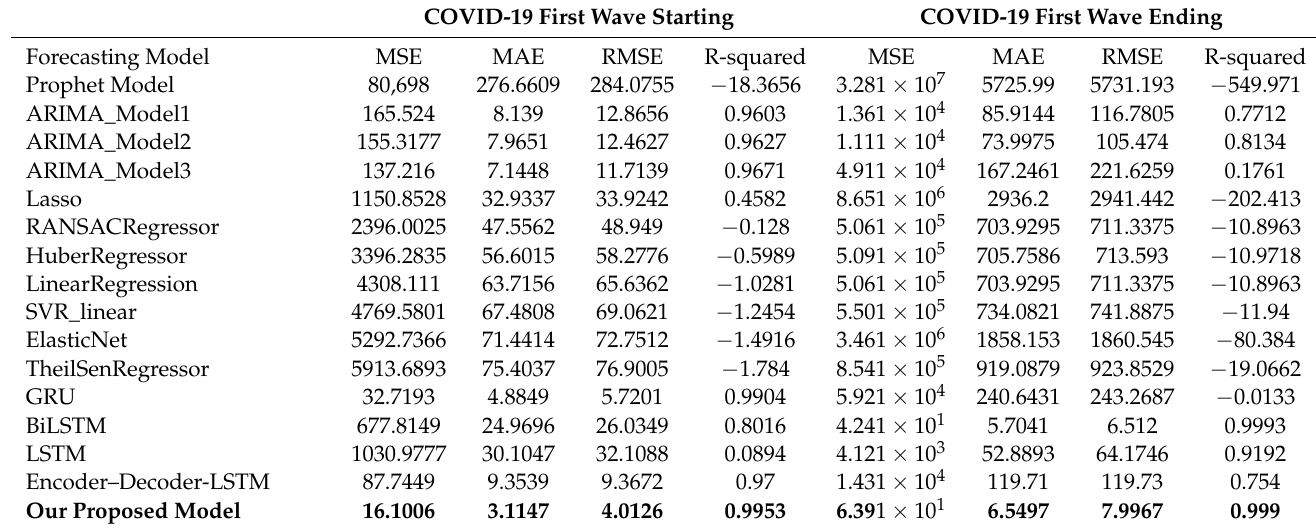
Table 4. A comparative analysis of our proposed approach with the previous methods based statistical evaluation criteria for death cases in Saudi